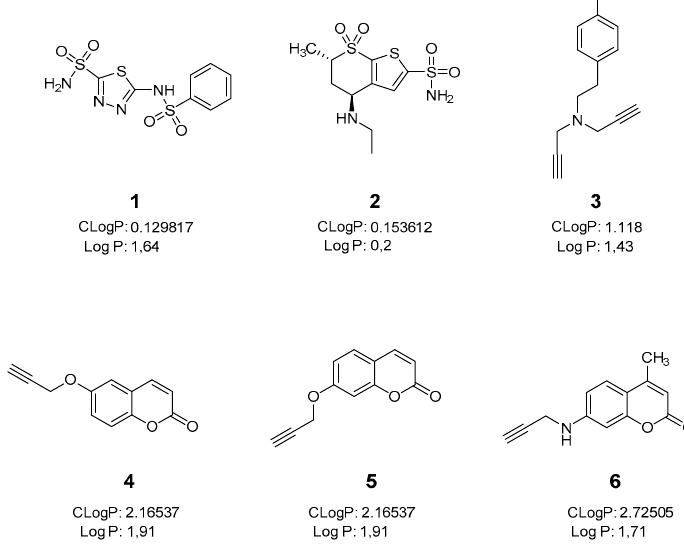
Figure 1 . Chemical structures of compounds 1 – 6 used in this study. Figure 1. Chemical structures of compounds 1 – 6 used in this